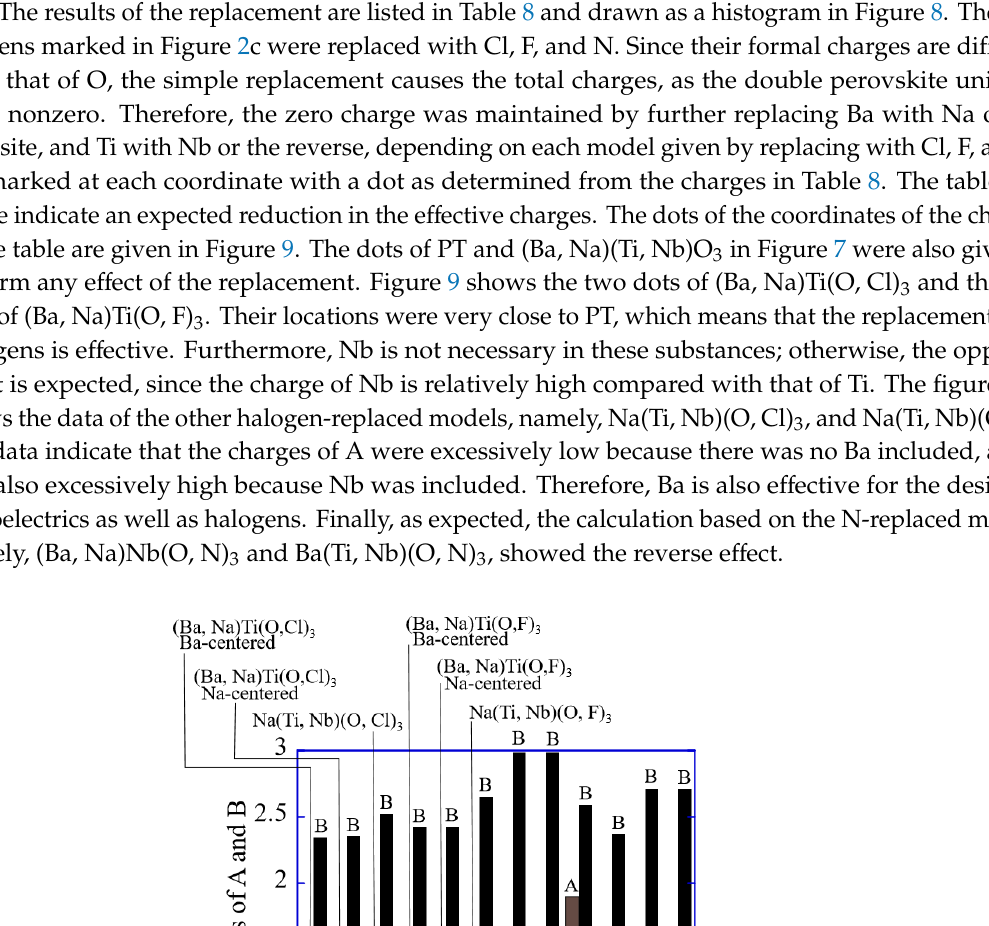
Figure 9. Map of the values in Table 8. The dots of PT and (Ba, Na)(Ti, Nb)O 3 in Figure 7 are given for comparison.